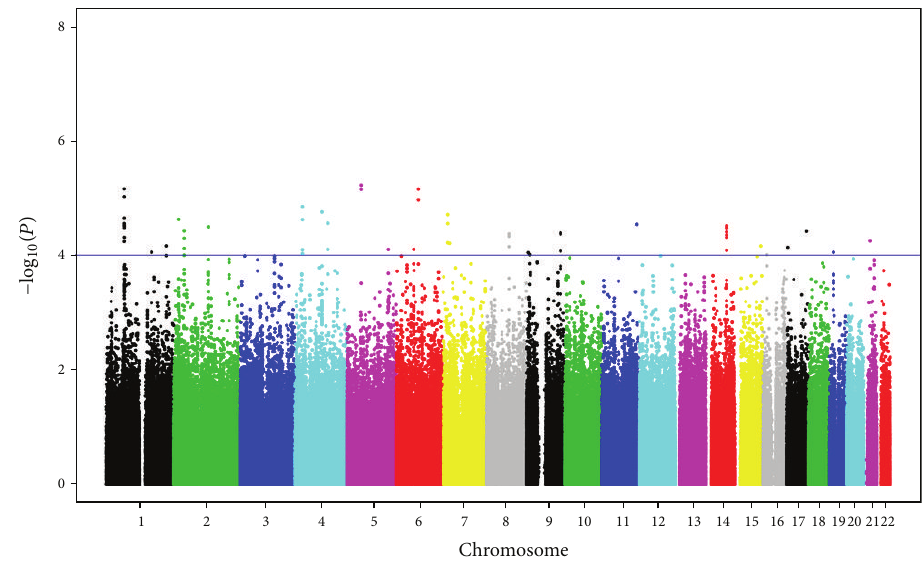
Figure 2: Manhattan plot showing the genome-wide association 𝑃 values with anticardiolipin antibodies (ACL). Blue line indicates 𝑃 = 1𝐸 − 04 .